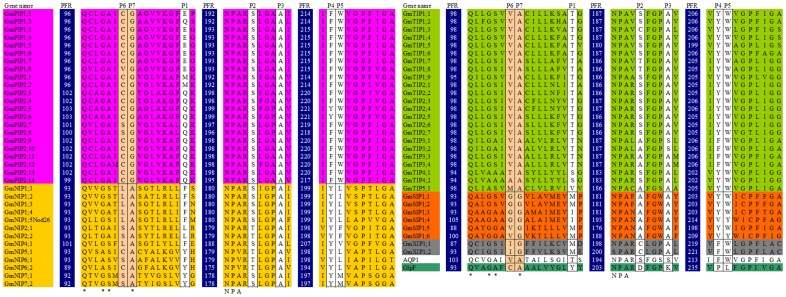
Portion of the 66 multiple sequence alignment.PFR stands for position of first residue in each sequence segment. The positions P1 to P5 predicted to have a functional role in MIP proteins are boxed. The positions P6 and P7 indicate the positions of residues to differentiate between the subfamilies.